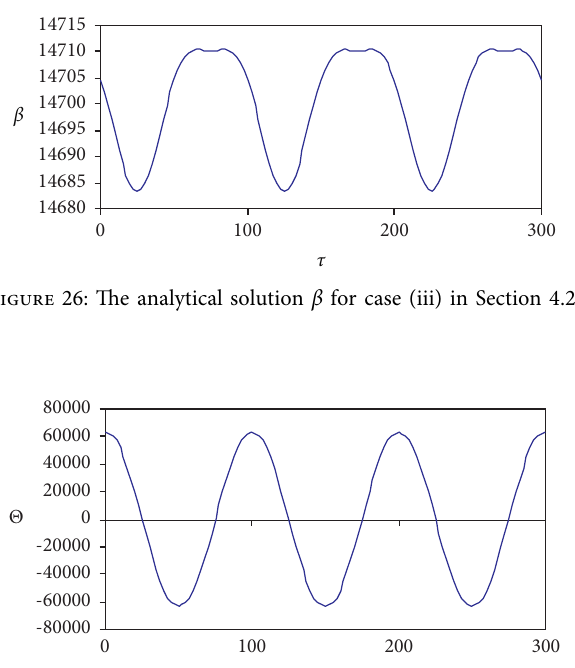
Figure 23: The stability phrase β ′ and β for case (ii) in Section 4.2.